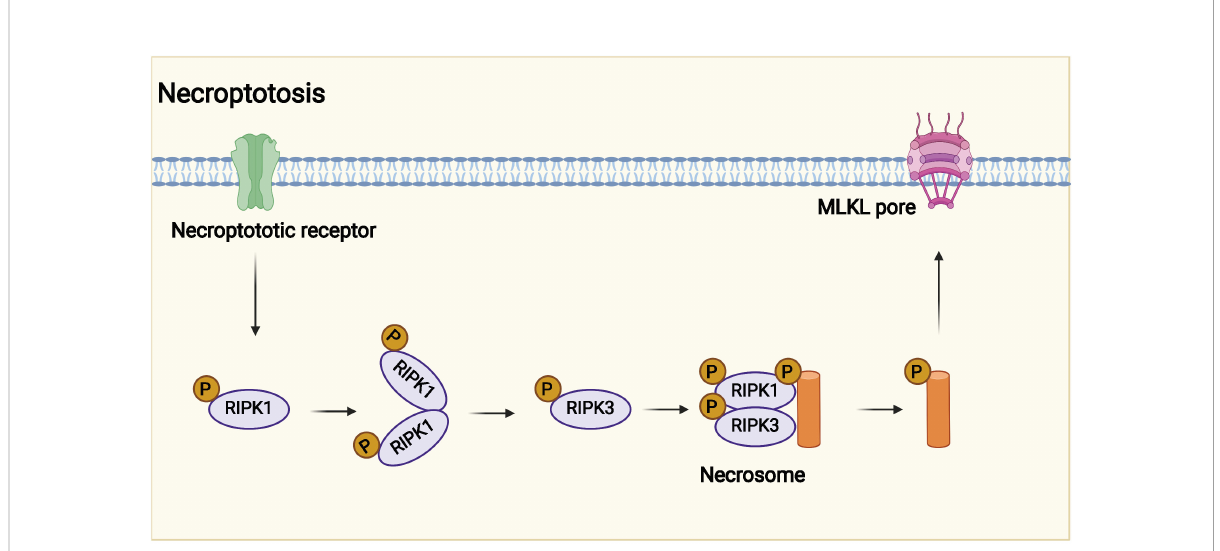
FIGURE 3 Potential mechanism of necroptosis. Necroptotic death may have evolved into the innate immune mechanism that complements apoptosis to eliminate pathogens. Necroptosis is affected by receptor interacting protein kinase 3 (RIPK3) and mixed lineage kinase domain-like protein